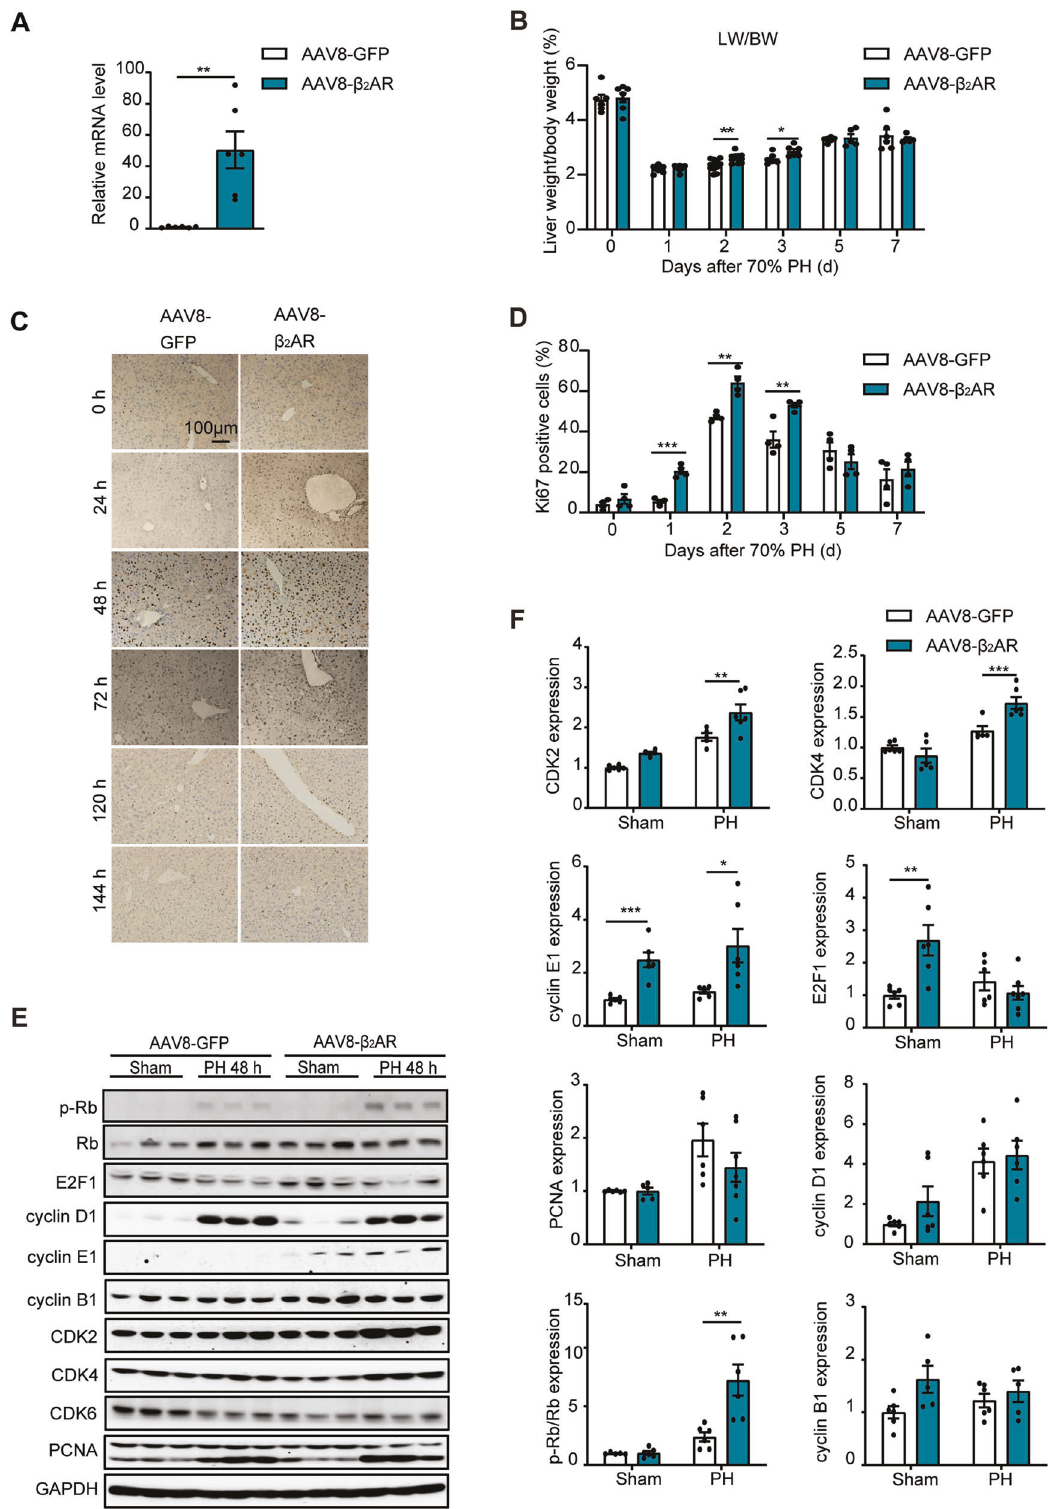
Fig. 4 Adeno-associated virus-mediated overexpression of β 2 AR promoted liver regeneration post PH. A RT – qPCR analysis of the mRNA expression of β 2 AR ( n = 6). B Liver weight to body weight ratio ( n = 5 – 11). C Ki67 staining of mouse livers at the indicated times post PH ( n = 4). D The percentage of Ki67-positive cells was measured ( n = 4). E The protein levels of cell cycle markers in AAV8-GFP and AAV8- β 2 AR mouse livers 48 h post PH ( n = 5 – 7). F Quantitative analysis of immunoblotting ( n = 5 – 7). Data are means ± SEM. * P < 0.05, ** P < 0.01, *** P < 0.001 with a two-tailed Student ’ s t test.